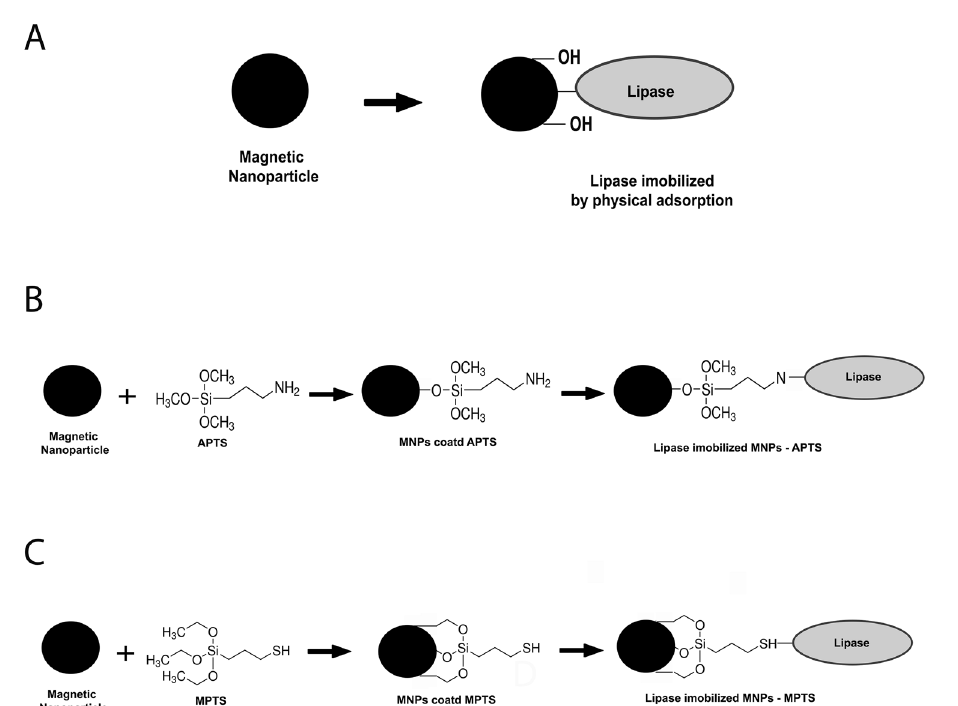
Figure 4. Schematic representation of immobilization of lipases by physical adsorption ( A ), immobilization by covalent coupling using the APTS ligand ( B ), and immobilization by covalent coupling using the MPTS ligand ( C